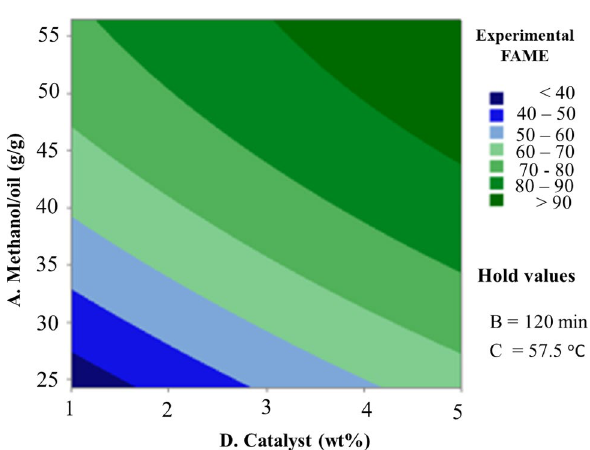
Figure 7. Contour plot of experimental FAME vs. (A) Methanol/oil (D) Catalyst.